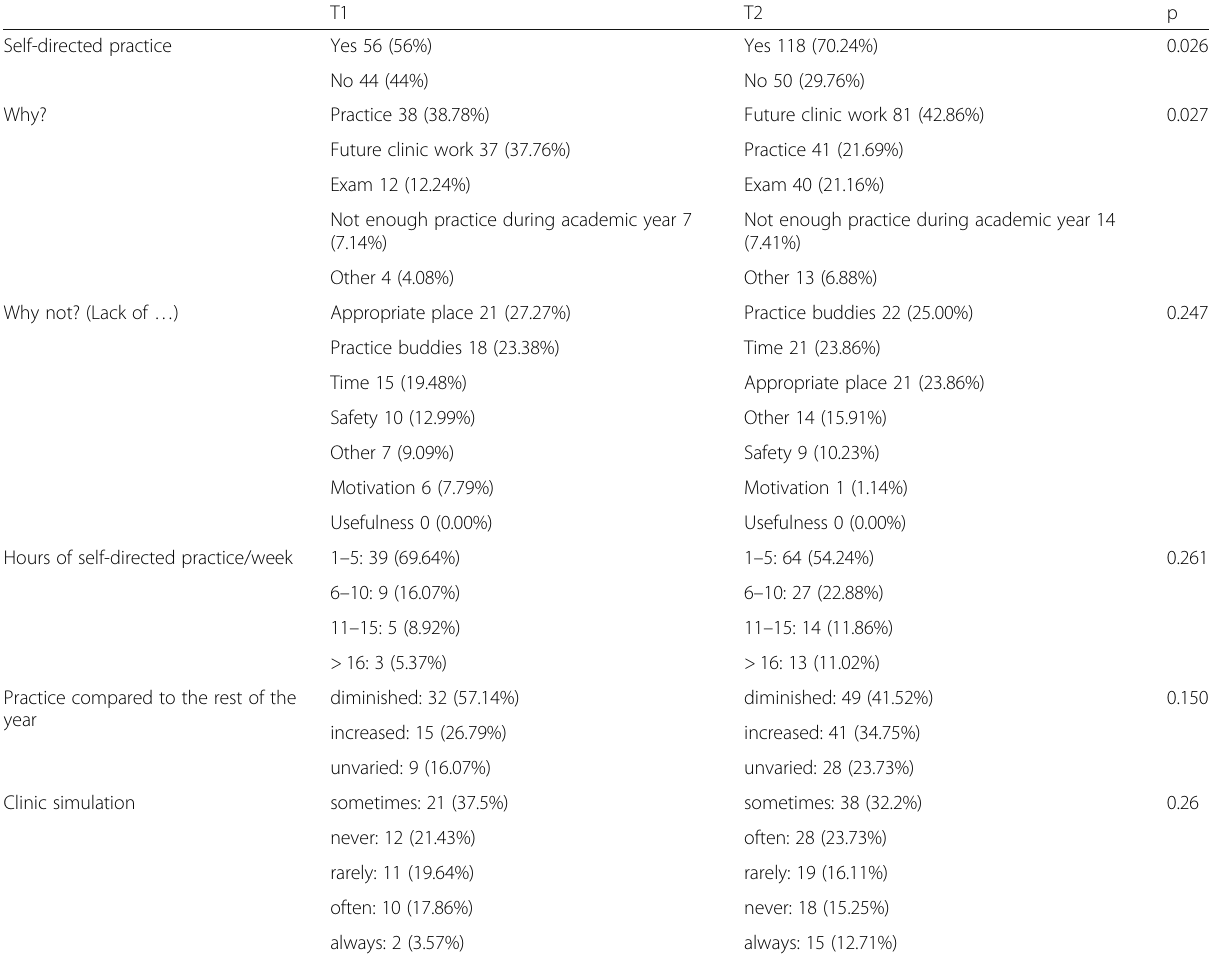
Table 2 Self-directed practice between T1 and T2